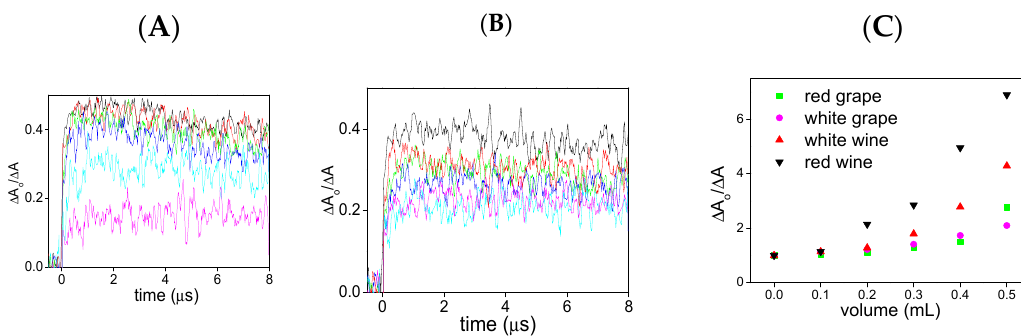
Figure 4. Kinetic traces recorded at 390 nm after laser flash photolysis irradiation ( λ exc = 355 nm) of deaerated acetonitrile solutions of NPT (0.29 mM) and TS (7.5 mM) with increasing volumes of freshly squeezed juice (0–0.5 mL): commercial red grapes of Monastrell variety ( A ), commercial white grapes of Rosseti variety ( B ). ( C ) Corresponding Stern–Volmer plots.